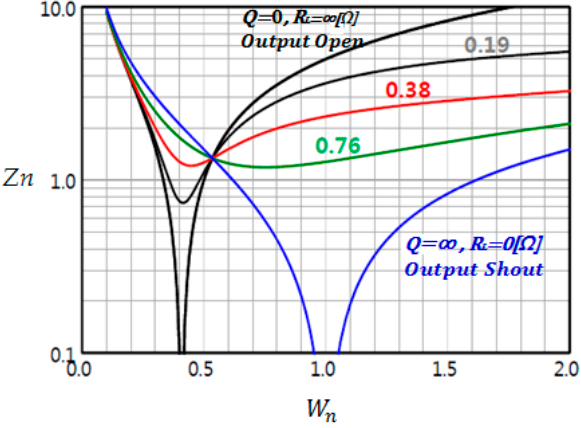
Figure 5. Input impedance and frequency characteristic graph of the LLC resonant converter.